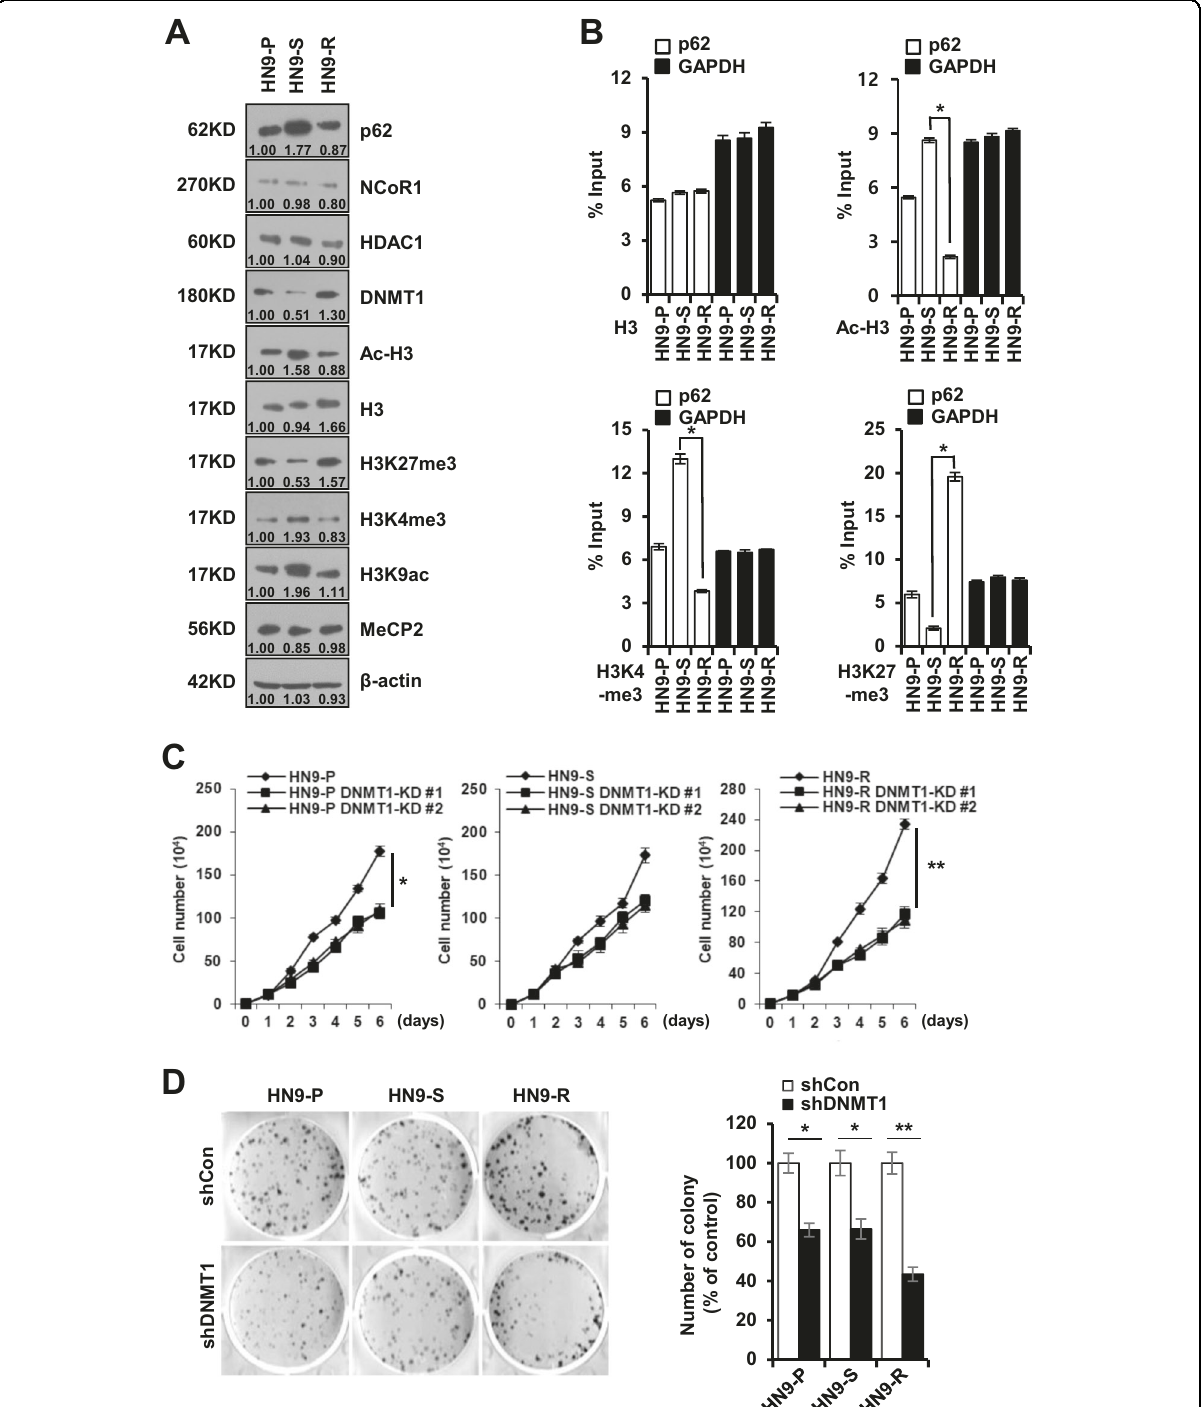
Fig. 3 Transcriptional repression of p62 via DNA methylation increases in vitro tumorigenicity of HN9-R clones. A Western blot analysis of p62, NCoR1, HDAC1, DNMT1, and histone modi fi cation proteins in HN9 cells. The numbers below the gel lines represent the protein level relative to HN9-P cells, which was determined form the band intensity and normalized by β -actin. B Variation in H3 modi fi cations on the p62 promoter in HN9 cells. The ChIP assay shows transcriptionally active histone markers (Ac-H3 and H3K4me3) enriched on the promoter in HN9-S and an inactive marker (H3K27me3) detected on the promoter in HN9-R. The results obtained from three independent biological replicates were represented as percentage of input (% input). C , D Proliferative capacity ( C ) and colony formation ( D ) of DNMT1-depleted HN9 cells. Results are presented as means ± standard error of the mean (SEM). * p < 0.05; ** p <